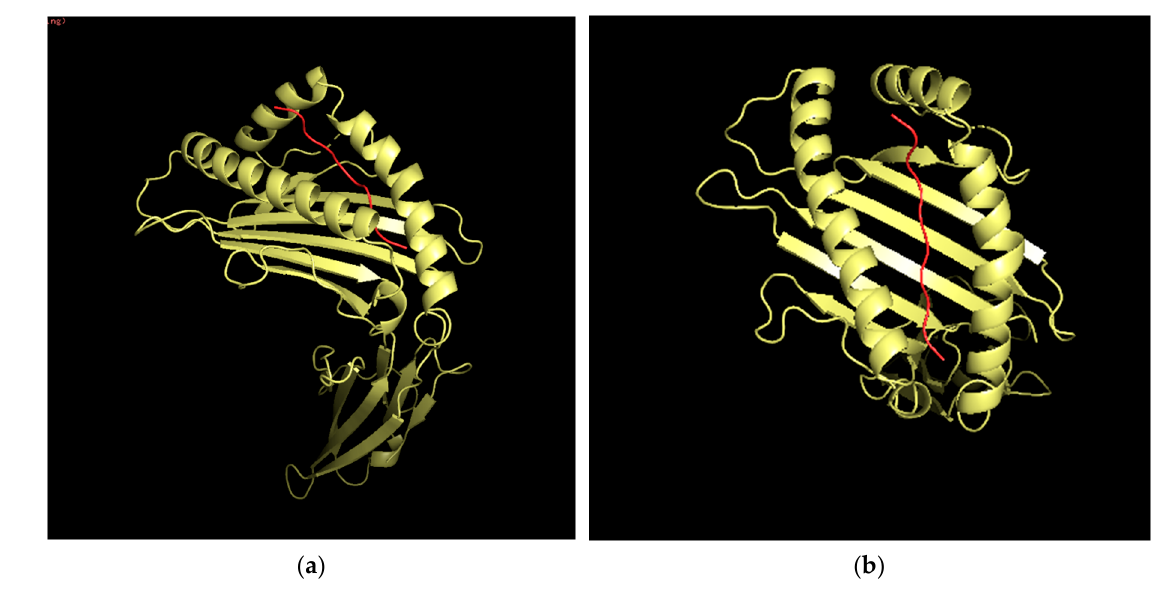
Figure 8. Three ‐ dimensional structure of epitope VVVGACDVGK docked in HLA allele HLA ‐ Figure 8. Three-dimensional structure of epitope VVVGACDVGK docked in HLA allele HLA-A*68:01. A*68:01. Red is the epitope sequence. Yellow is the HLA ‐ A*68:01 molecule. ( a ) provides a frontal Red is the epitope sequence. Yellow is the HLA-A*68:01 molecule. ( a ) provides a frontal view of the view of the MHC ‐ peptide complex. ( b ) provides a top ‐ down view of the MHC ‐ peptide complex. MHC-peptide complex. ( b ) provides a top-down view of the MHC-peptide complex.